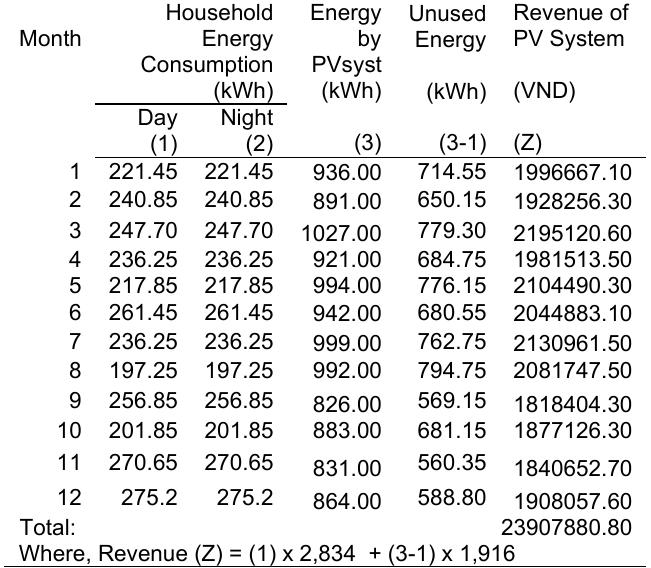
Table 6. Energy consumption and profitability of the rooftop solar PV system